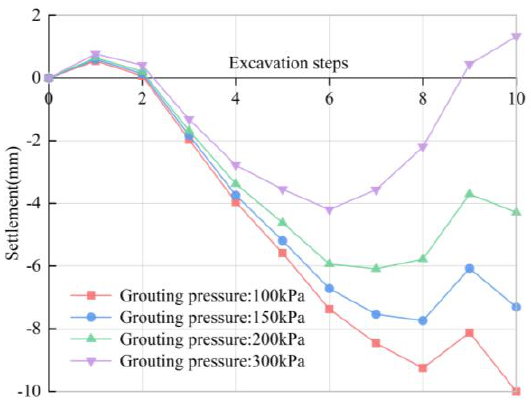
Figure 14. Influence of grouting pressure on the longitudinal deformation of the ground surface.